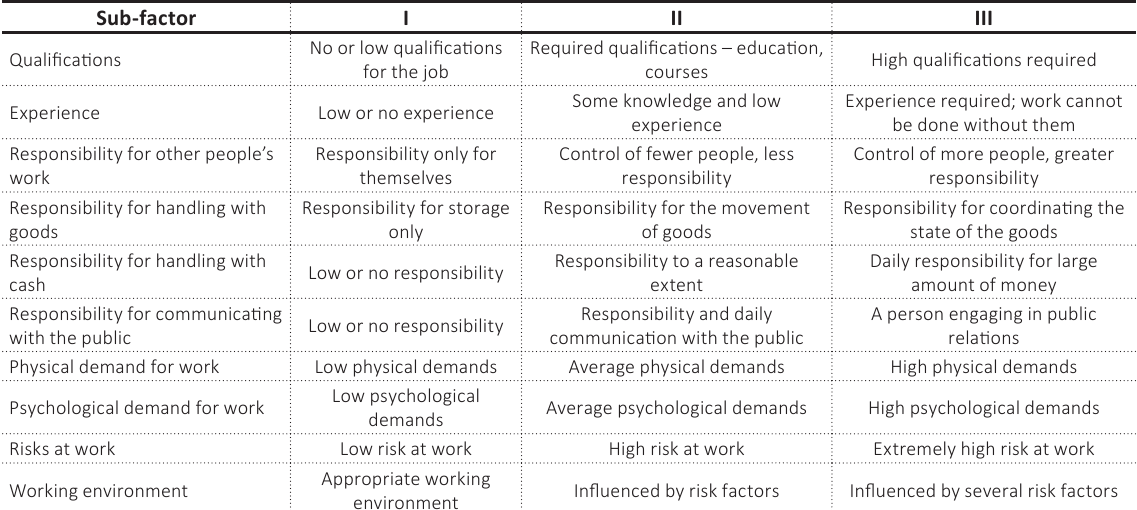
Table 3. Quantitative scale of job evaluation